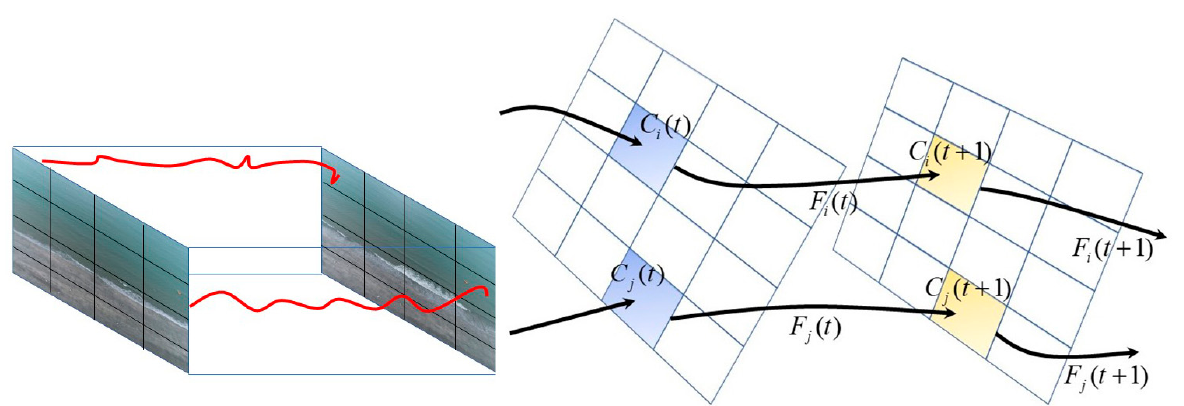
Figure 3. Each grid has its own bundled path, consisting of a sequence of homography.